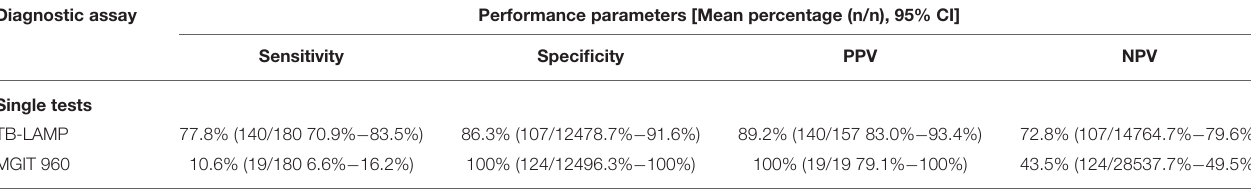
TABLE 2 | Performance of TB-LAMP in the diagnosis of TB empyema with etiology as the reference standard. Diagnostic assay